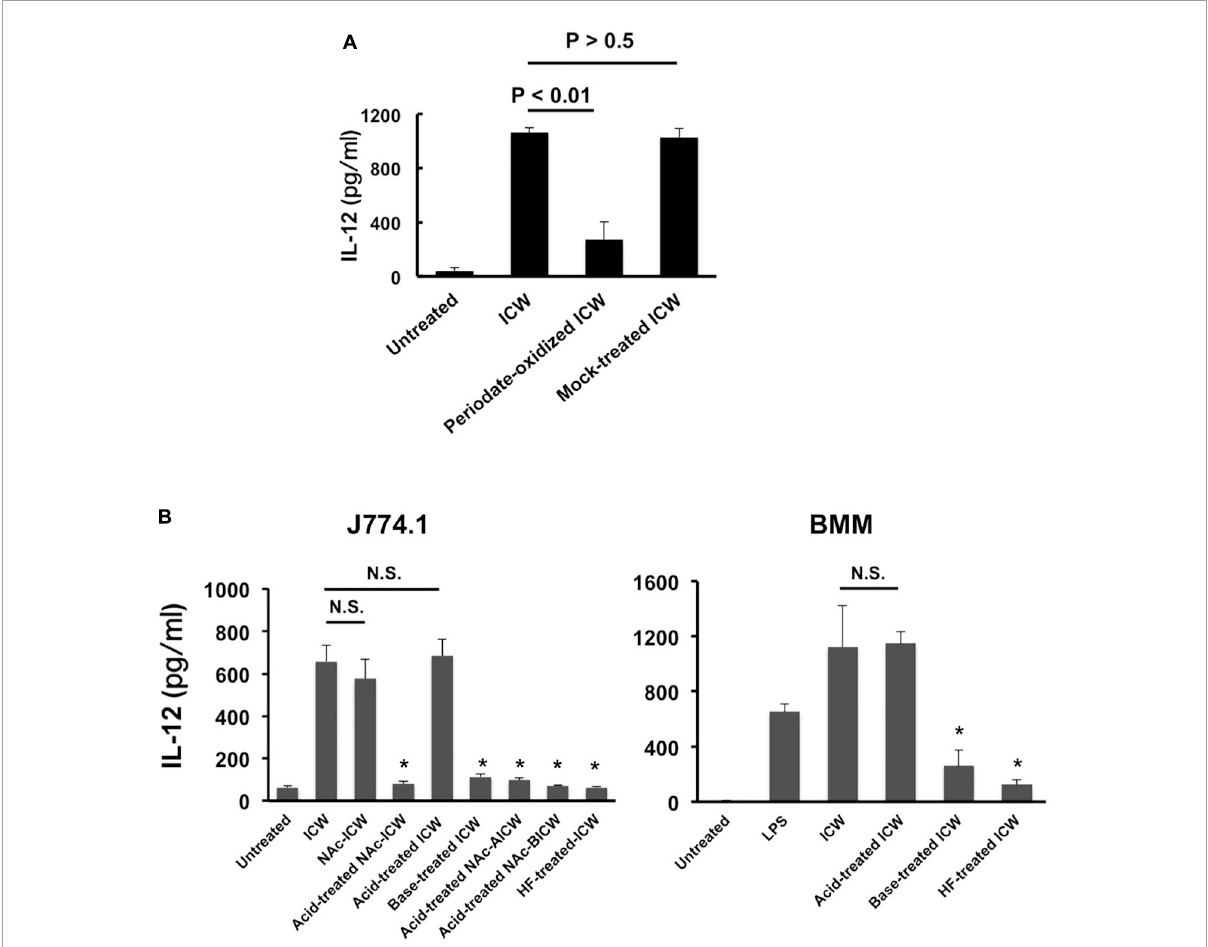
FIGURE5 IL-12 secretion from macrophages stimulated with chemically modified ICWs of L. plantarum TUA 5099L. (A) J774.1 cells were cultured with unmodified, periodate-oxidized or mock-treated ICWs (each 10 µ g/ml) for 24 h and IL-12 secreted in each supernatant was determined. Each bar is the mean ± SE for three independent experiments. (B) J774.1 cells or BMMs were cultured with chemically modified or unmodified ICWs (10 µ g/ml) for 24 h and IL-12 secreted in the culture supernatant was determined. Each bar is the mean ± SE for 4 (for J774.1 cells) and 3 (for BMMs) experiments. Significance was evaluated by one-way ANOVA. N.S., not significant vs. ICW treated cells. * P < 0.01 vs. cells treated with unmodified